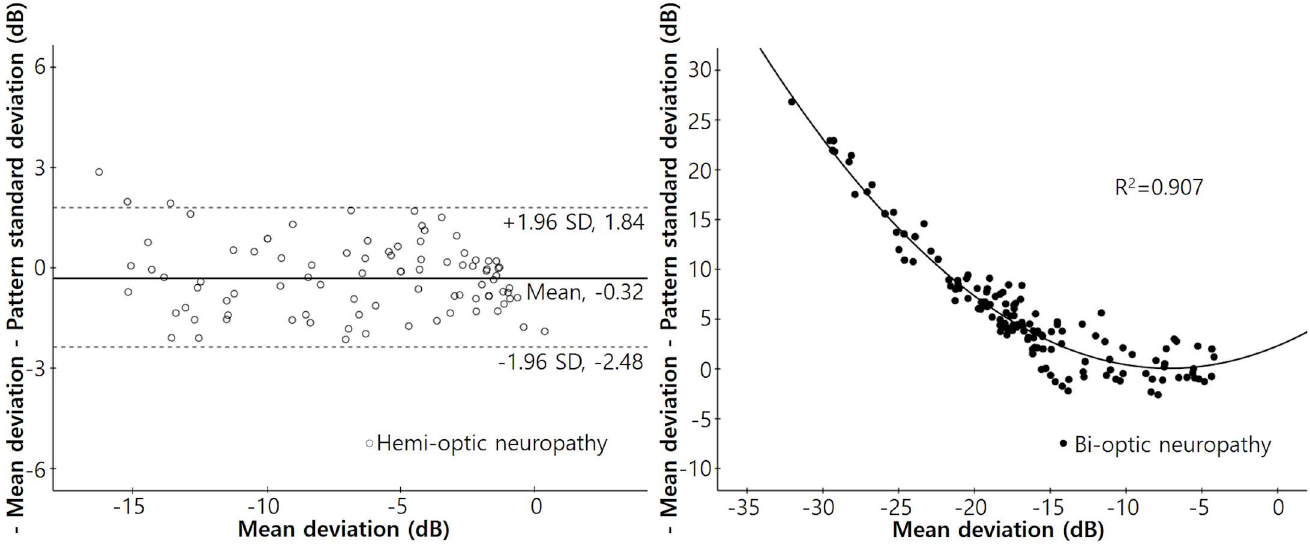
Fig 3. Scatterplots of the differences between negative MD and PSD values with respect to the MDs in each group. Left: A scatterplot of the difference betweenthe negativeMD and PSD values (‘ − MD − PSD’) with respect to the MDs of patients with hemi-optic neuropathy(either superioror inferior) (r 2 = 0.019, P = 0.191). The mean ‘ − MD − PSD’was − 0.32 dB, and the 95% confidenceinterval rangedfrom − 2.48 dB to 1.84 dB. Right: A scatterplot of “ − MD − PSD”in terms of the MDs of patients with bi-opticneuropathy(thus both superiorand inferior). The “ − MD − PSD” increased significantly as MD decreased. The correlations were calculatedusing the followingequation:Y = 2.320 + 0.632X + 0.044X 2 (r 2 = 0.907, P < 0.001).